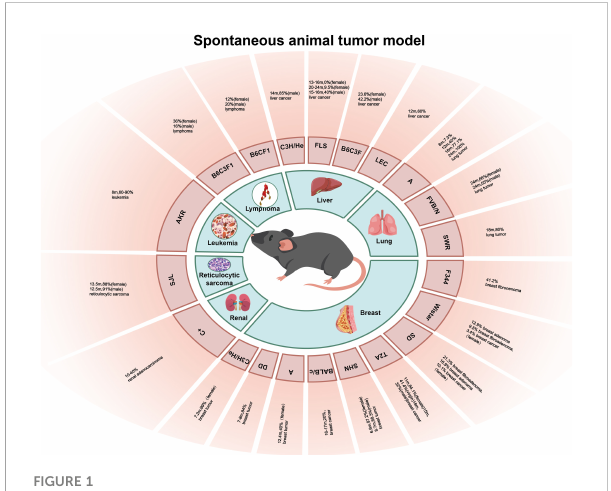
FIGURE 1 The incidence of various spontaneous tumors in different strains of mice